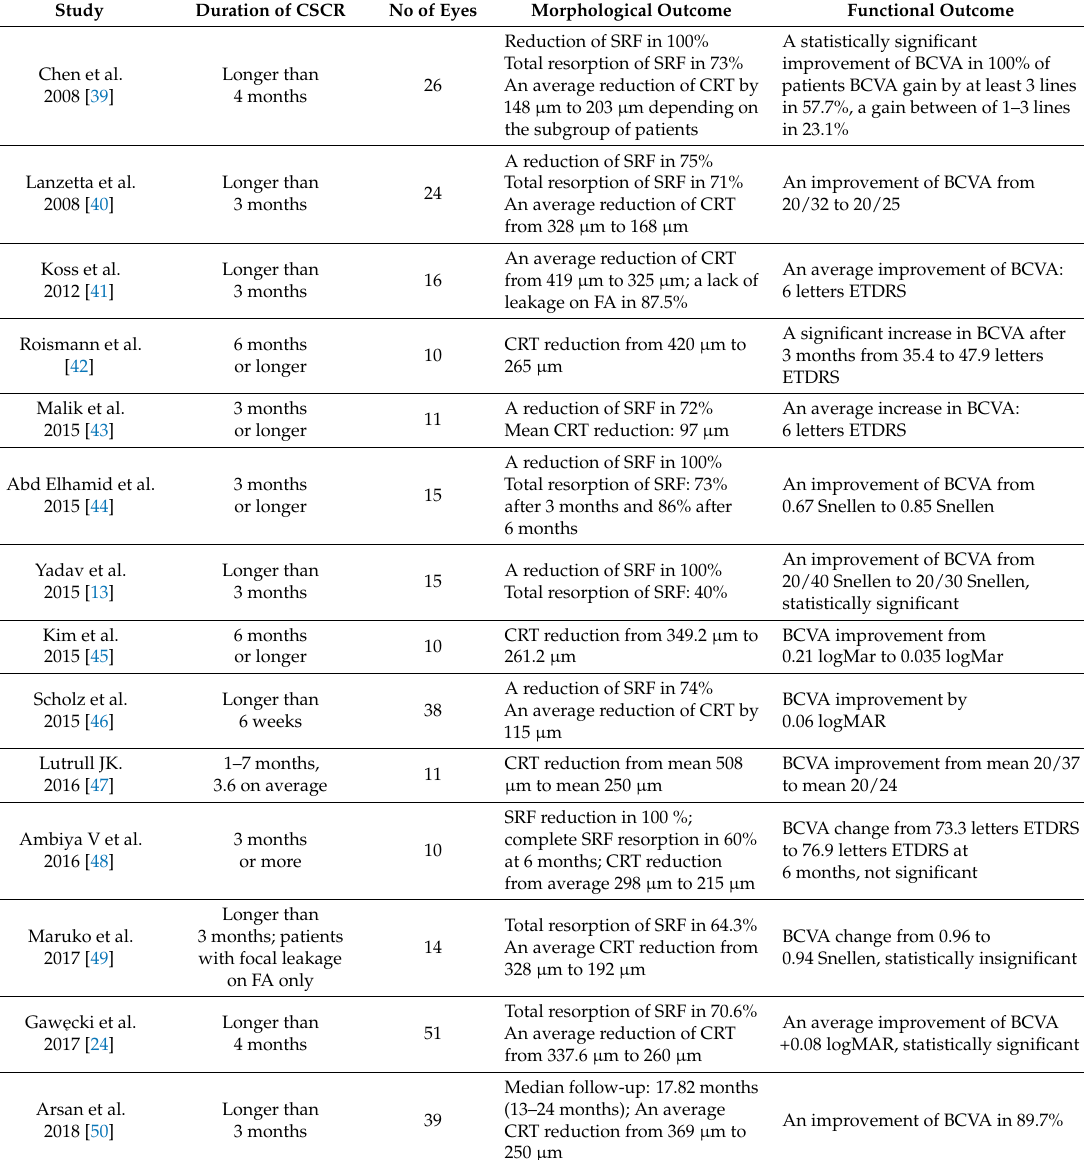
Table 1. Efficacy of SMPLT in the treatment of CSCR in major clinical trials. CSCR: central